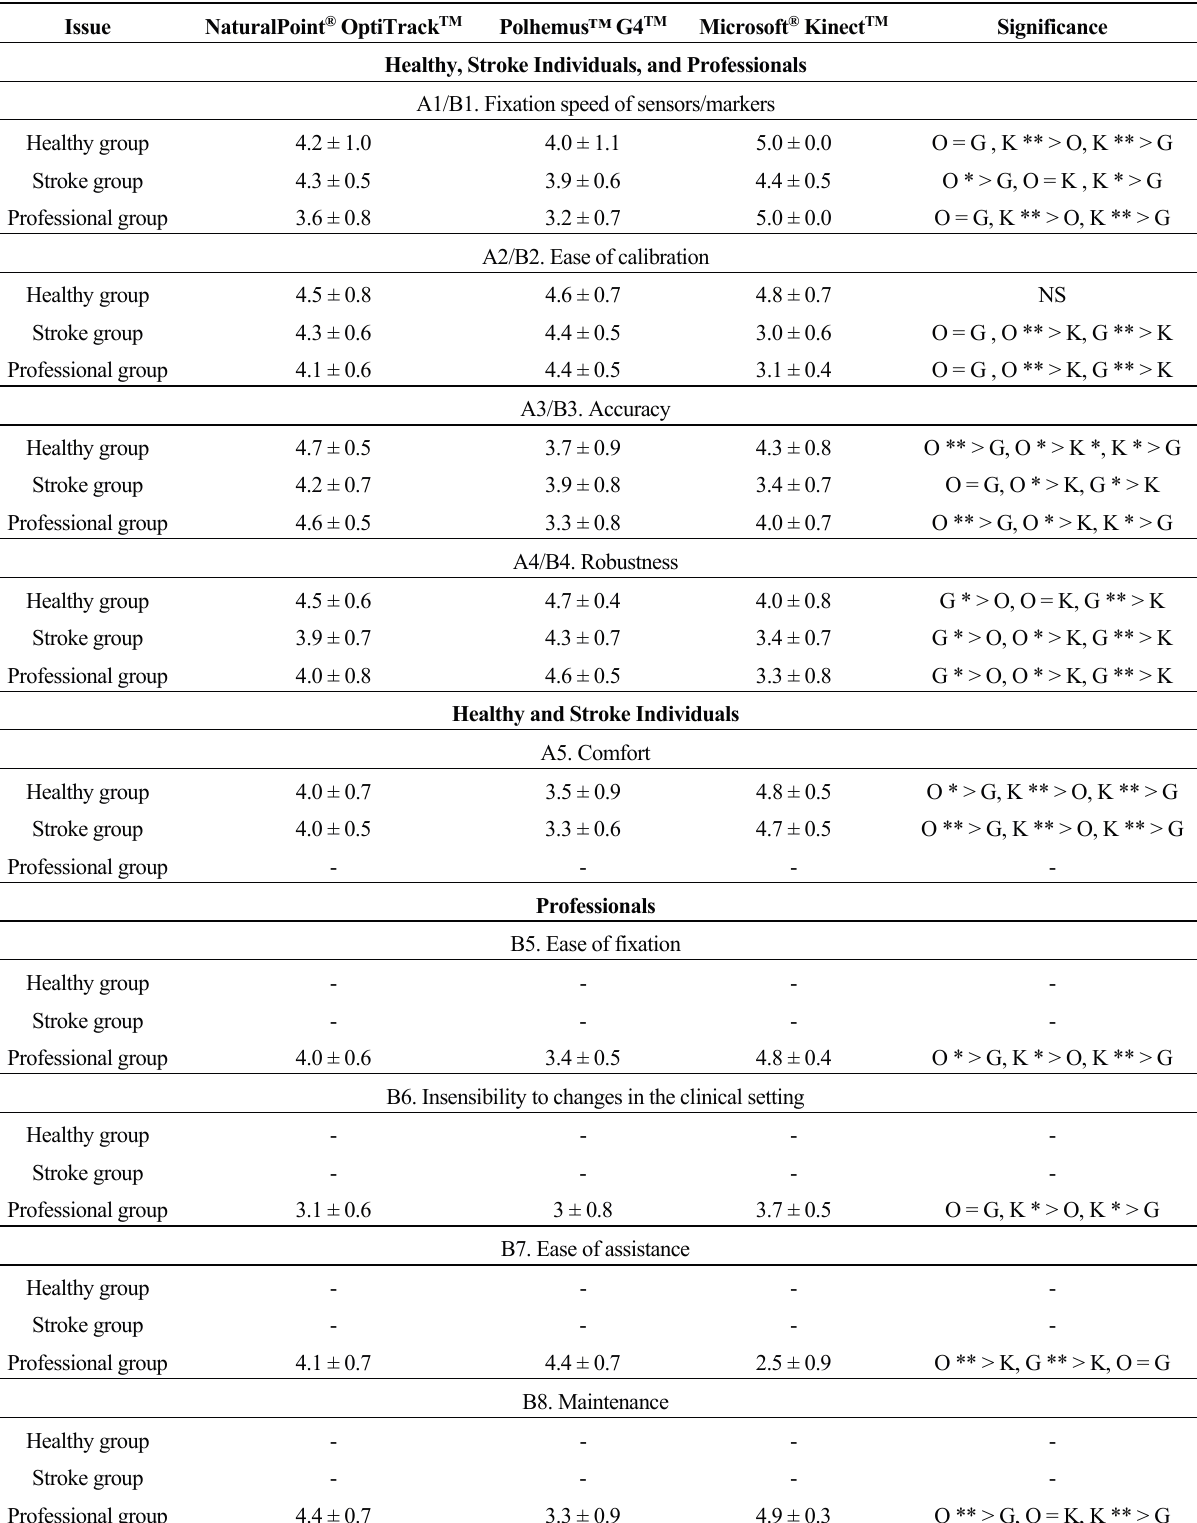
Table 3. Subjective experiences. The table shows the scores of each group to the subjective questionnaires. Results are defined in terms of mean and standard deviation. Only significant differences are